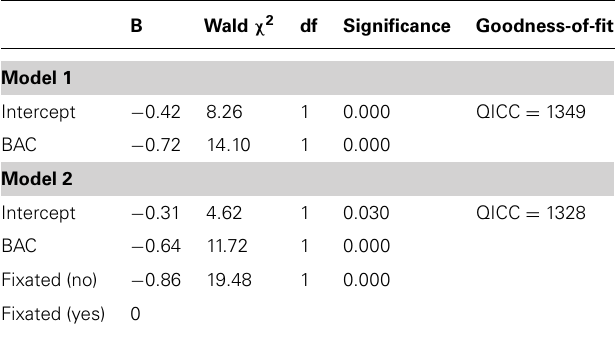
Table 5 | Effect of alcohol intoxication on brand recall controlling for ad attention